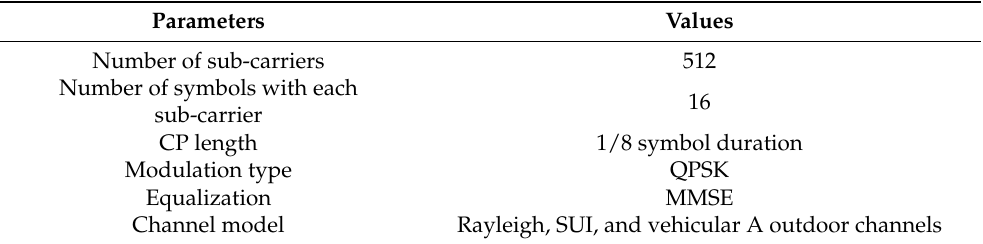
Table 2. Simulation